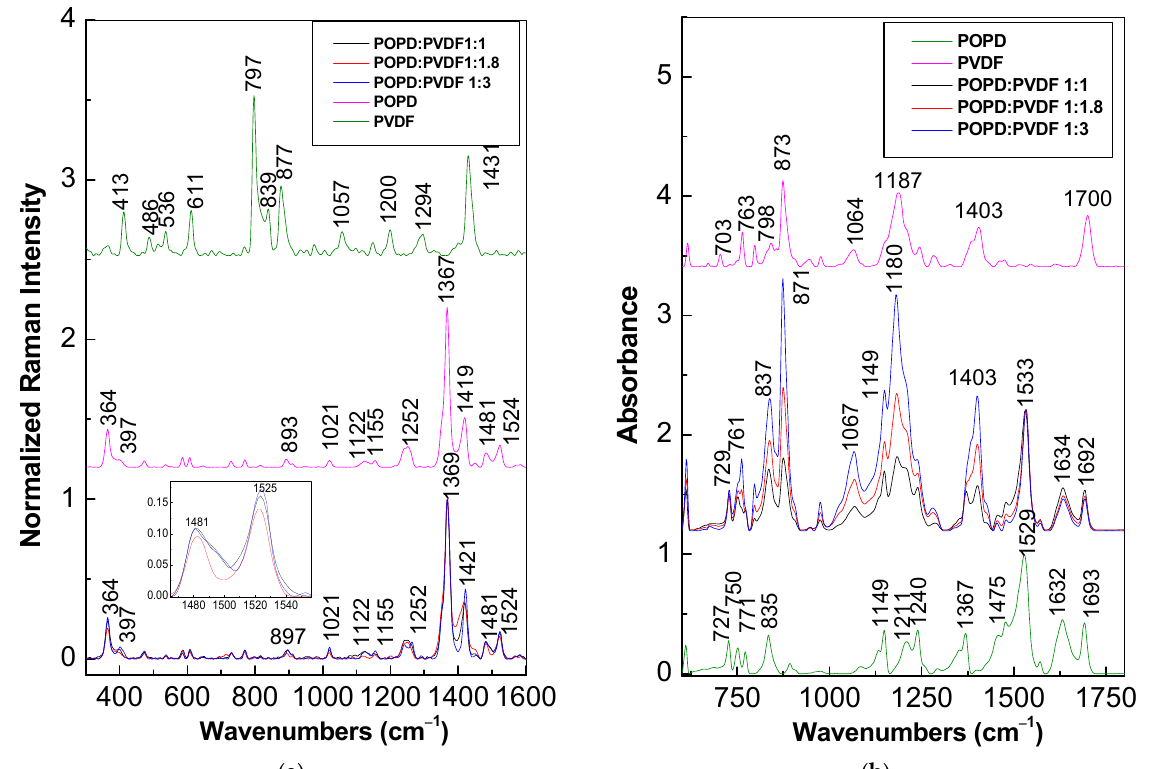
Figure 4. Raman ( a ) and IR ( b ) spectra of the samples labeled as A1, B1 and C1. Regardless of the ratio between the concentrations of OPD and PVDF, the Raman spectra of the A, B and C samples (Figure 3a) are characterized by Raman lines peaked at 366, 889, 1250, 1369, 1421, and 1524 cm − 1 which were assigned to the following vibrational modes of POPD: quinoid ring deformation, out of plane C-H bending in benzene nuclei of phenazine skeleton, C-N stretching in quinoid imide units, C-N + , phenazine like structure and C=N stretching in phenazine structure, respectively [31,32]. The Raman line peaked at around 399 cm − 1 (Figure 3a) belongs to the T2 symmetrical vibrational mode of [FeCl 4 ] − ions, which compensates the positive charges existing on the macromolecular chain of POPD [33]. The Raman lines having maxima at 1020, 1124 and 1481–1483 cm − 1 (Figure 3a) are not located far from the lines calculated by the density-functional theory which were reported to be situated at 1014, 1117 and 1477 cm − 1 ; they were assigned to the following vibrational modes of α - PVDF: CH 2 torsion (A g ), symmetrical stretching of the C-C bond (A u) and CH 2 deformation + CH 2 wagging (A g ) [34,35]. According to Figure 3a, when increasing the PVDF weight in the mixture of the chemical polymerization reaction of OPD one observes: (i) an increase in the relative intensity of the Raman line situated in the spectral range 1430–1490 cm − 1 ; (ii) a gradual shift of the Raman line from 1481 cm − 1 (A sample) to 1483 cm − 1 (B sample) and 1488 cm − 1 (C sample); (iii) the ratio between the intensities of the Raman lines peaked at 1481–1488 and 1524 cm − 1 varies from 0.55 (A sample) to 0.57 (B sample) and 0.67 (C sample). Taking into account that the Raman lines peaked at 1524 and 1481–1488 cm − 1 are assigned to the vibrational modes of C=N stretching in phenazine structure of PVDF and CH 2 deformation + CH 2 wagging of PVDF, the gradual increase of the ratio between the intensities of these two lines (I 1524 /I 1481–1488 ) form 0.55 (A sample) to 0.67 (C sample) indicates a higher weigh of the vibrational modes of PVDF in contrast with those of POPD. These results prove the increase of the PVDF weight in the A, B and C samples mass. In order to prove experimentally that the higher intensity of the vibrational modes of PVDF is not trivially due to the increase of the PVDF amount, Figure 4 shows the Raman and IR spectra of the samples prepared by the